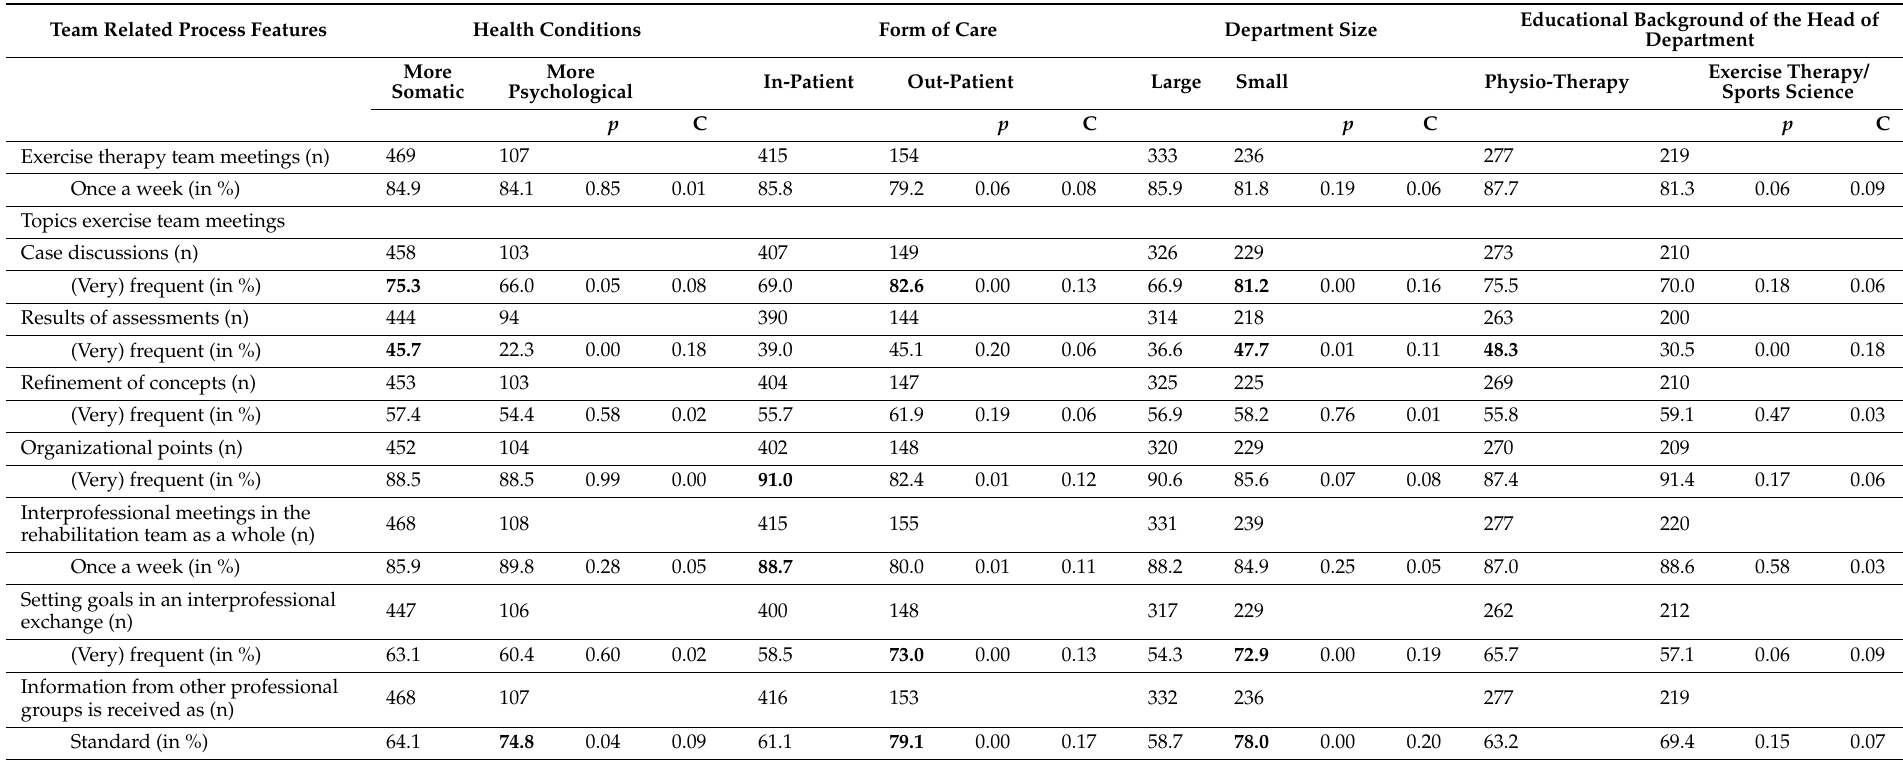
Table 4. χ 2 tests and contingency coefficient C for correlation analyses between team-related process features and structural features of exercise therapy